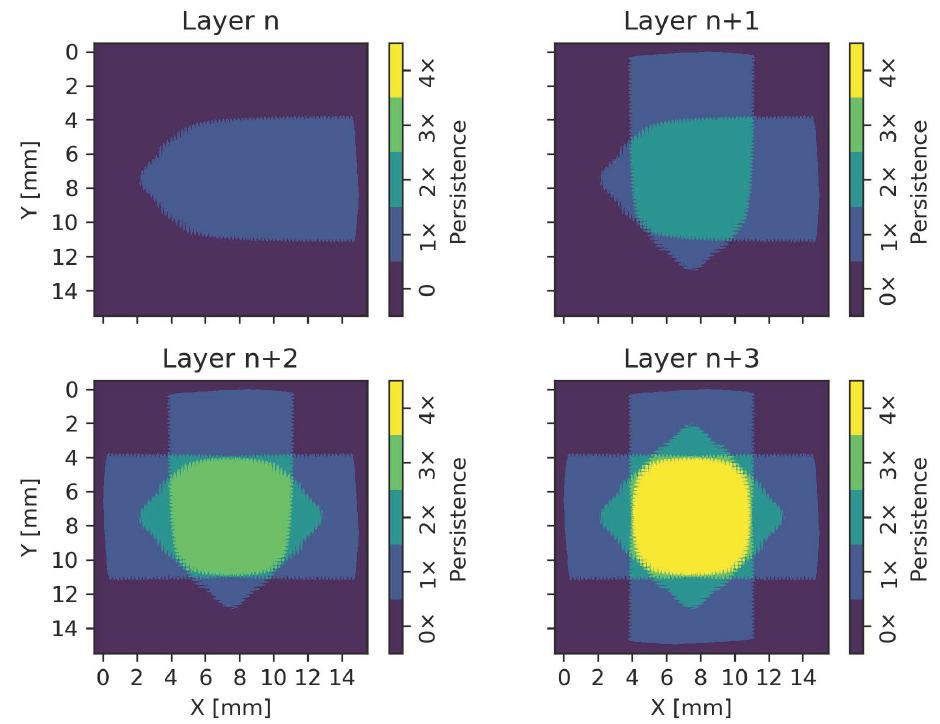
Figure 5. Superposition of permanent persistent regions due to a scan rotation of 90° after each layer. The color represents the number of scan rotations where a specific region shows permanent persistence. Lateral melt direction from left to right for layer n. Lateral melt direction turning anti-clockwise for layer n +